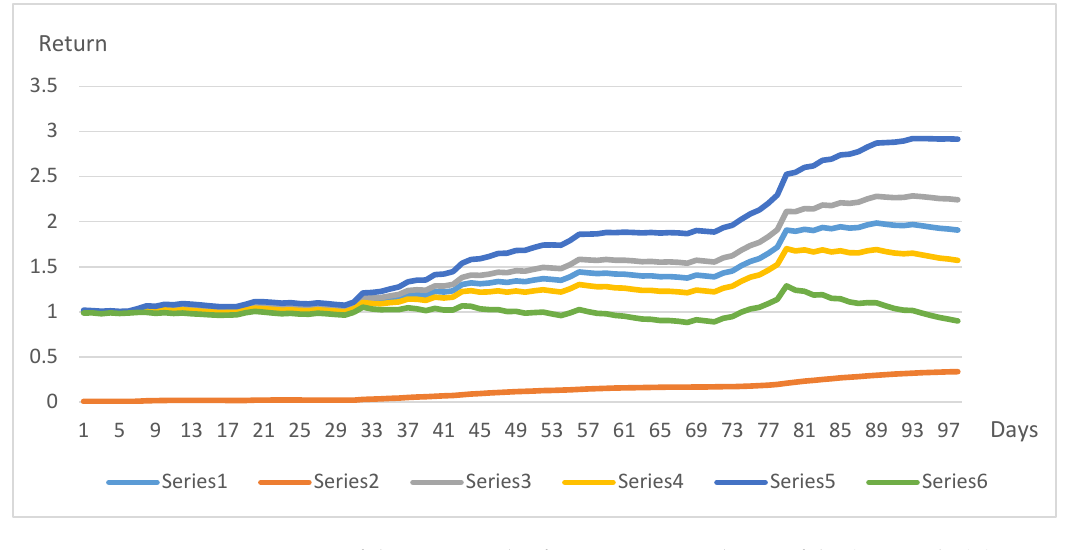
Figure 11. Confidence intervals of return on 30 stocks’ portfolio (UK market) (source: compiled by the authors based on Yahoo Finance data and own calculations).